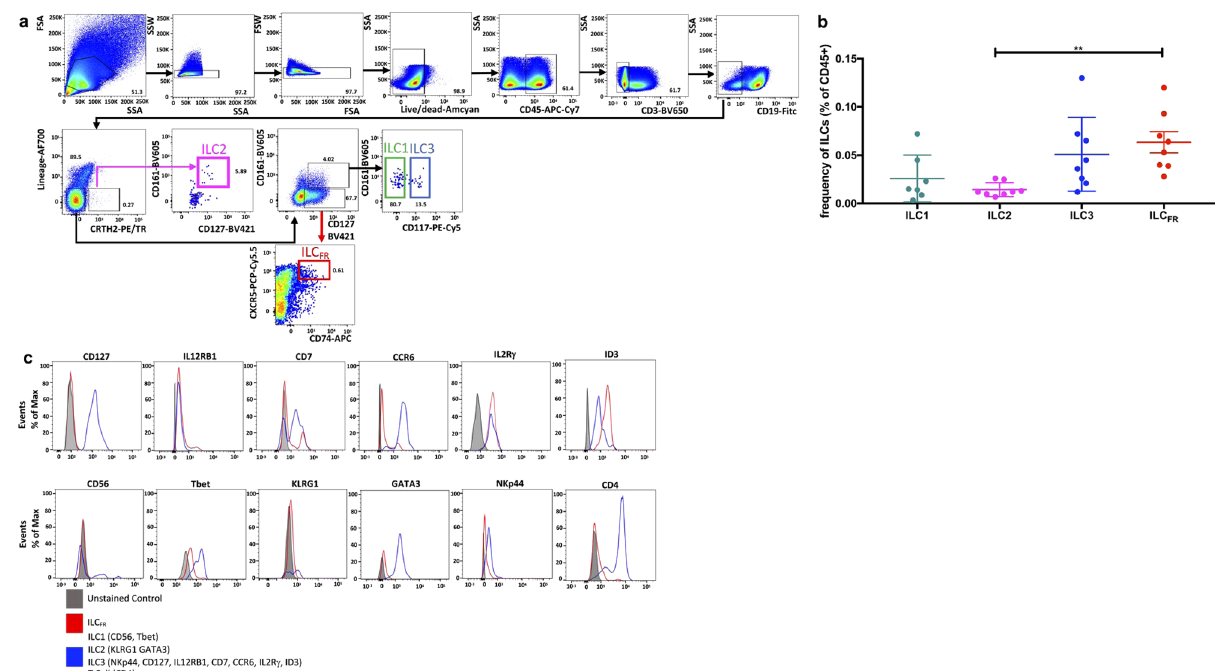
Fig. 1 A unique ILC population exists in human tonsils. a Representative conventional fl ow cytometry plots from an adult tonsil showing the hierarchical phenotype gating strategy from singlet lymphocytes to the ILC1 (green), ILC2 (pink), and ILC3 (blue) and a unique ILC subset (ILC FR ) (red) populations indicated by arrows and color-coded gates. (Lin = CD4, CD11b, CD11c, CD14, CD16). b Graph shows frequency of ILC1, ILC2, ILC3, and ILC FR among CD45 + human tonsil mononuclear cells ( n = 7 or 8 biologically independent tonsils per group, 3 independent experiments) (Ordinary one-way ANOVA with multiple comparisons; F = 5.2; ** p = 0.0058; Mean± SD). c Analysis of surface and transcription markers on ILC FR by fl ow cytometry. Gray histograms depict fl uorescence minus one (FMO) control of each antibody. Red lines indicate ILC FR . Blue lines denote ILC1 (for CD56, Tbet), ILC2 (KLRG1, GATA3), ILC3 (NKp44, ID3, CD127, ILR12RB1, CD7, CCR6, IL-2R γ ), and T cells (CD4) ( n = 10 biologically independent tonsils per group, 3 independent